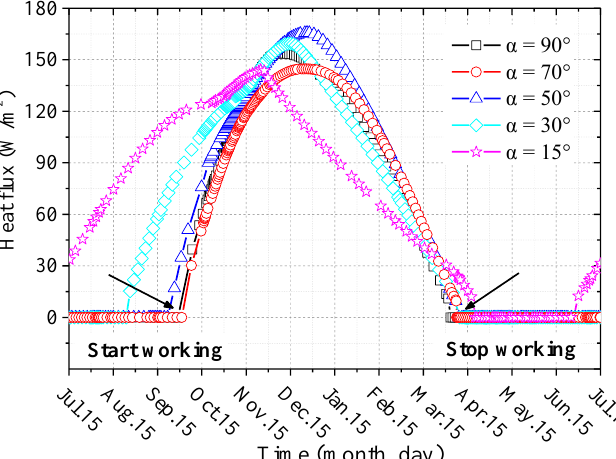
Figure 6. Variations in the heat flux at the outer walls of the evaporator sections of L-shaped TPCTs during the fifth year.